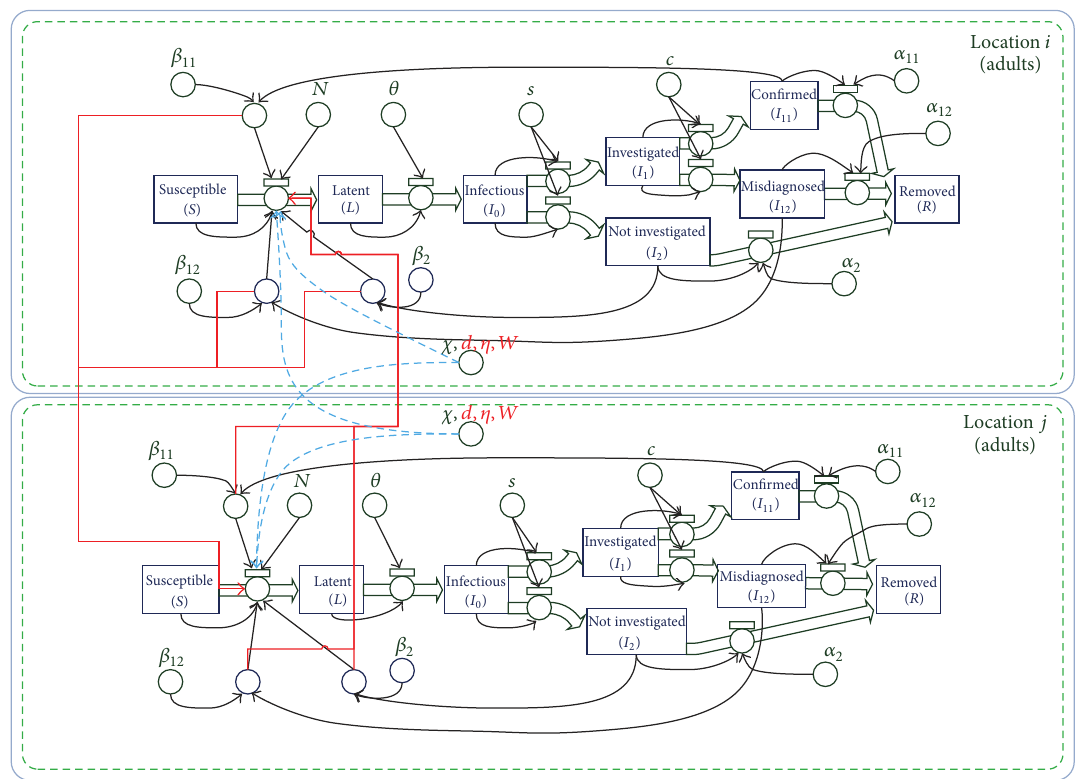
Figure 6: System dynamics flowchart of modified age-structured SLIR compartmental model in layer 2 of the FLUed model. Properties associated with commuting between two locations are indicated by red lines. Additional location properties are indicated by blue lines.